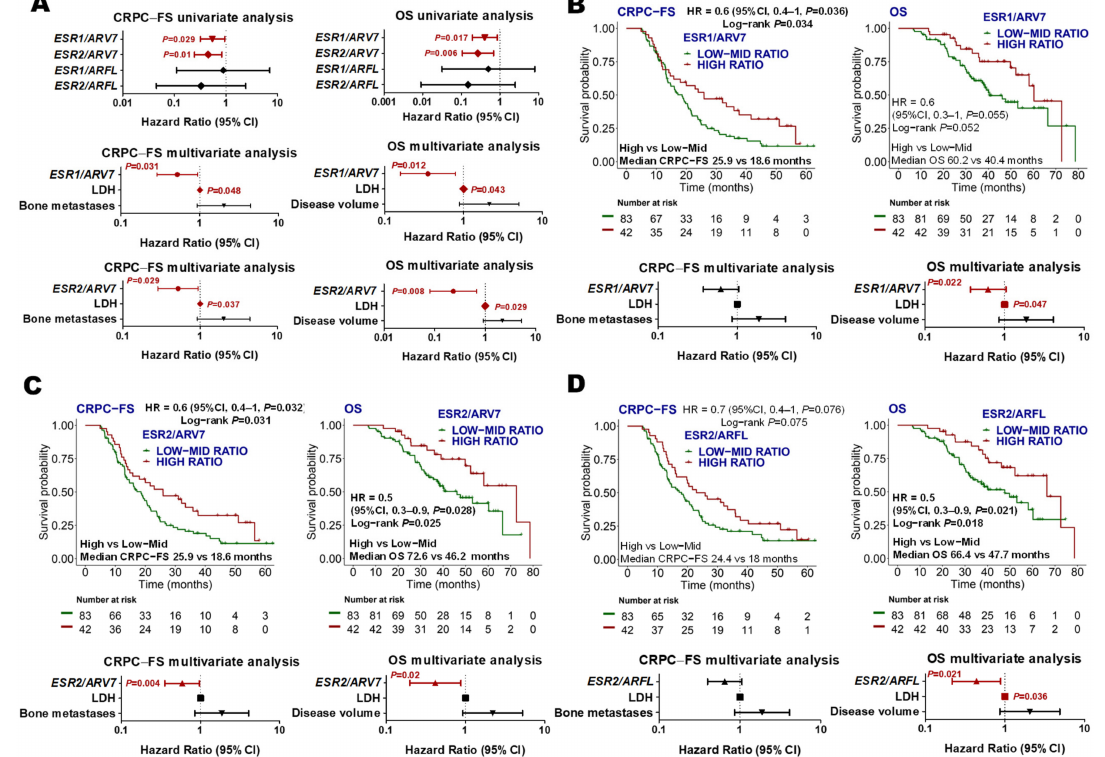
Figure 4. ESR/AR expression ratios. ( A ) Forest plots representing the univariate and multivariate analysis of the ratios between ESR and AR genes as continuous variables for CRPC-FS and OS. Those ratios with p < 0.1 in the univariate were included in the multivariate analysis; (B-D) Kaplan–Meier curves representing CRPC-FS and OS according to ESR1/ARV7 ( B ), ESR2/ARV7 ( C ), and ESR2/ARFL ( D ) ratios segregated into tertiles and forest plots representing the multivariate analysis. LDH: lactate dehydrogenase; HR: hazard ratio; CI, confidence